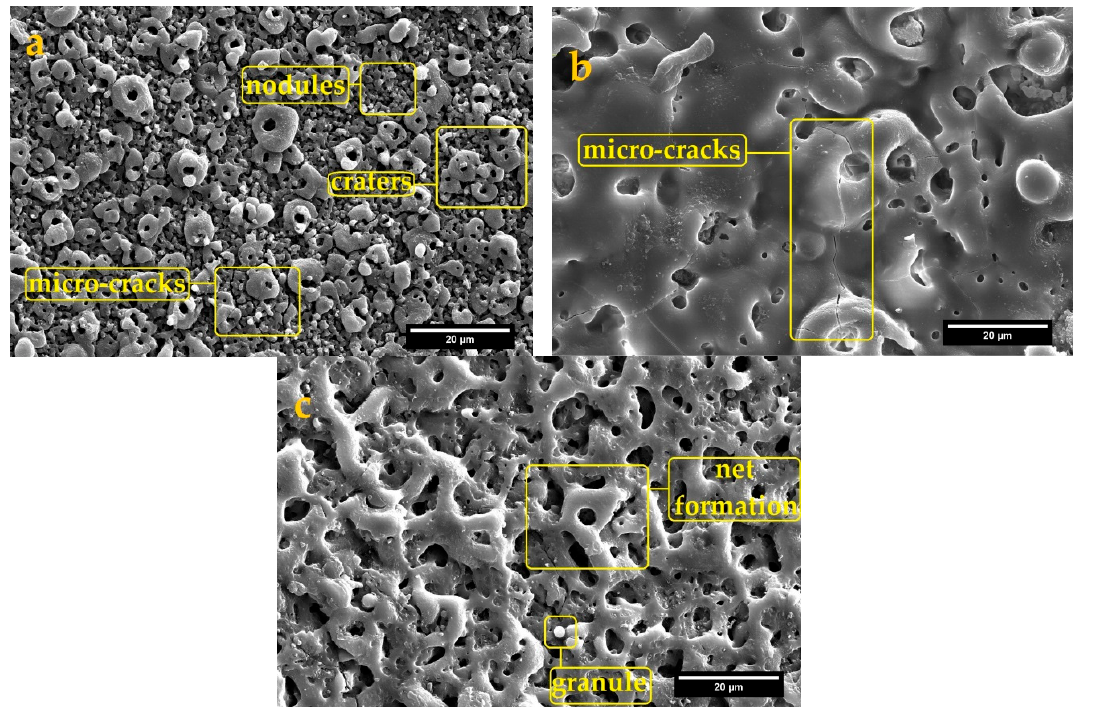
Figure 2. Surface morphology of PEO coatings produced in solutions containing aluminate, phosphate, and silicate: ( a ) Al, ( b ) Ph, and ( c ) Si. Table 2. Porosity percentage, thickness, and roughness measurements of Al, Ph, and Si